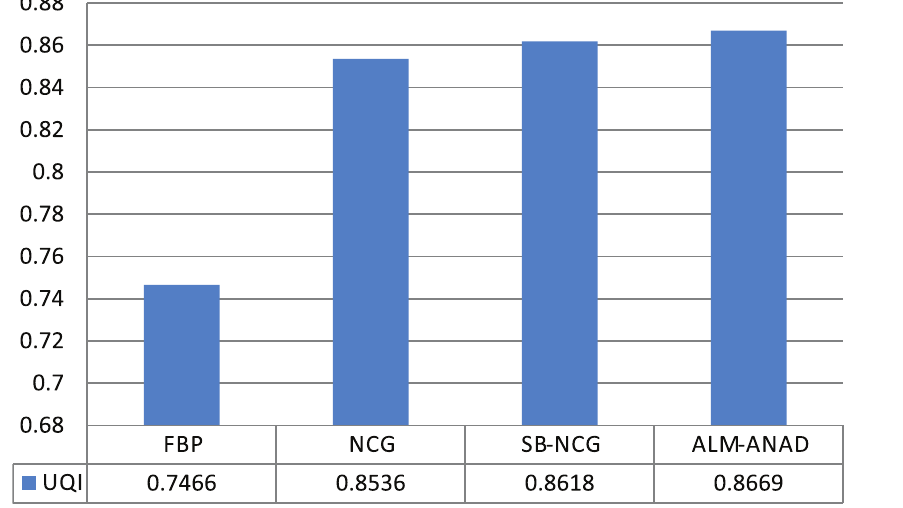
Fig 9. UQI measures of images reconstructed by four different